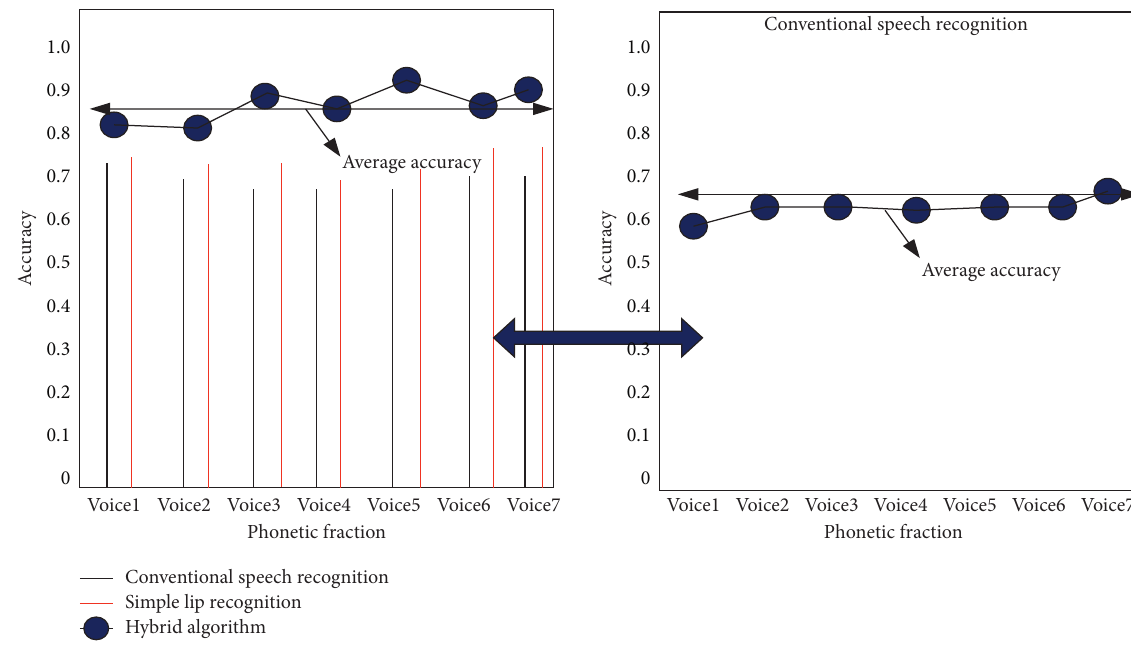
Figure 7: Comparison of average speech recognition accuracy of test